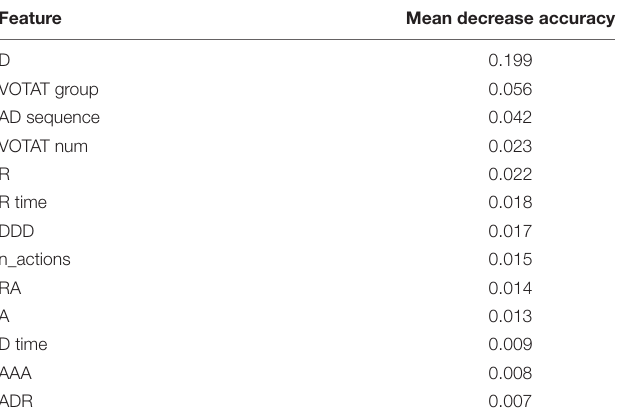
TABLE 7 | Features ranked by permutation importance measure (mean decrease